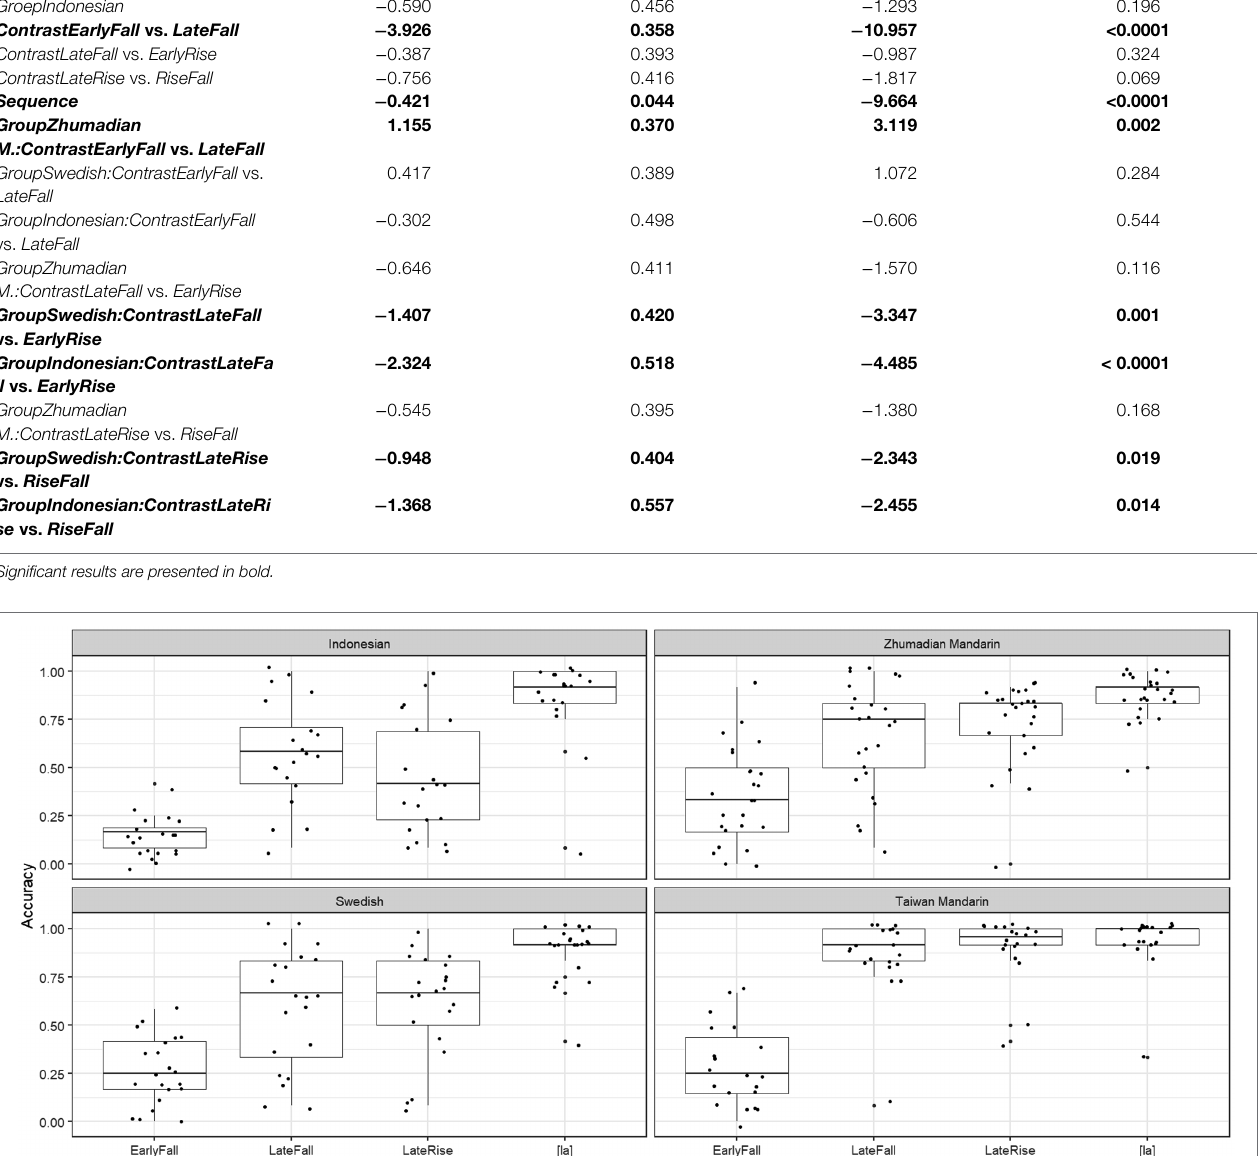
the interactions between the pitch contrasts and the language groups in the mixed-effects models. The Zhumadian group, whose language is the only one to have a temporal alignment contrast for falls, outperformed both the Swedish and Taiwan Mandarin groups on the EarlyFall vs. LateFall contrast, in